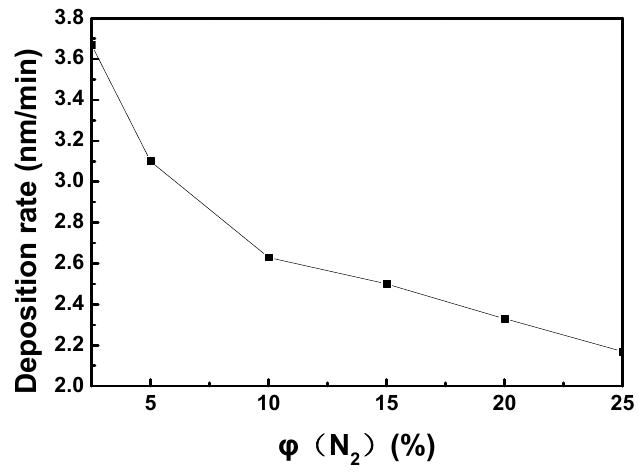
Figure 4. Relationship between nitrogen flow ratio and film deposition rate.